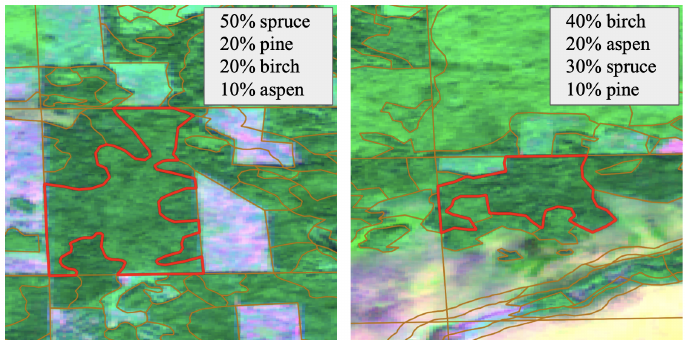
Figure 4. Composite of B12, B08, B04 Sentinel-2 bands (tile id is L2A_T36VWN_A010343_